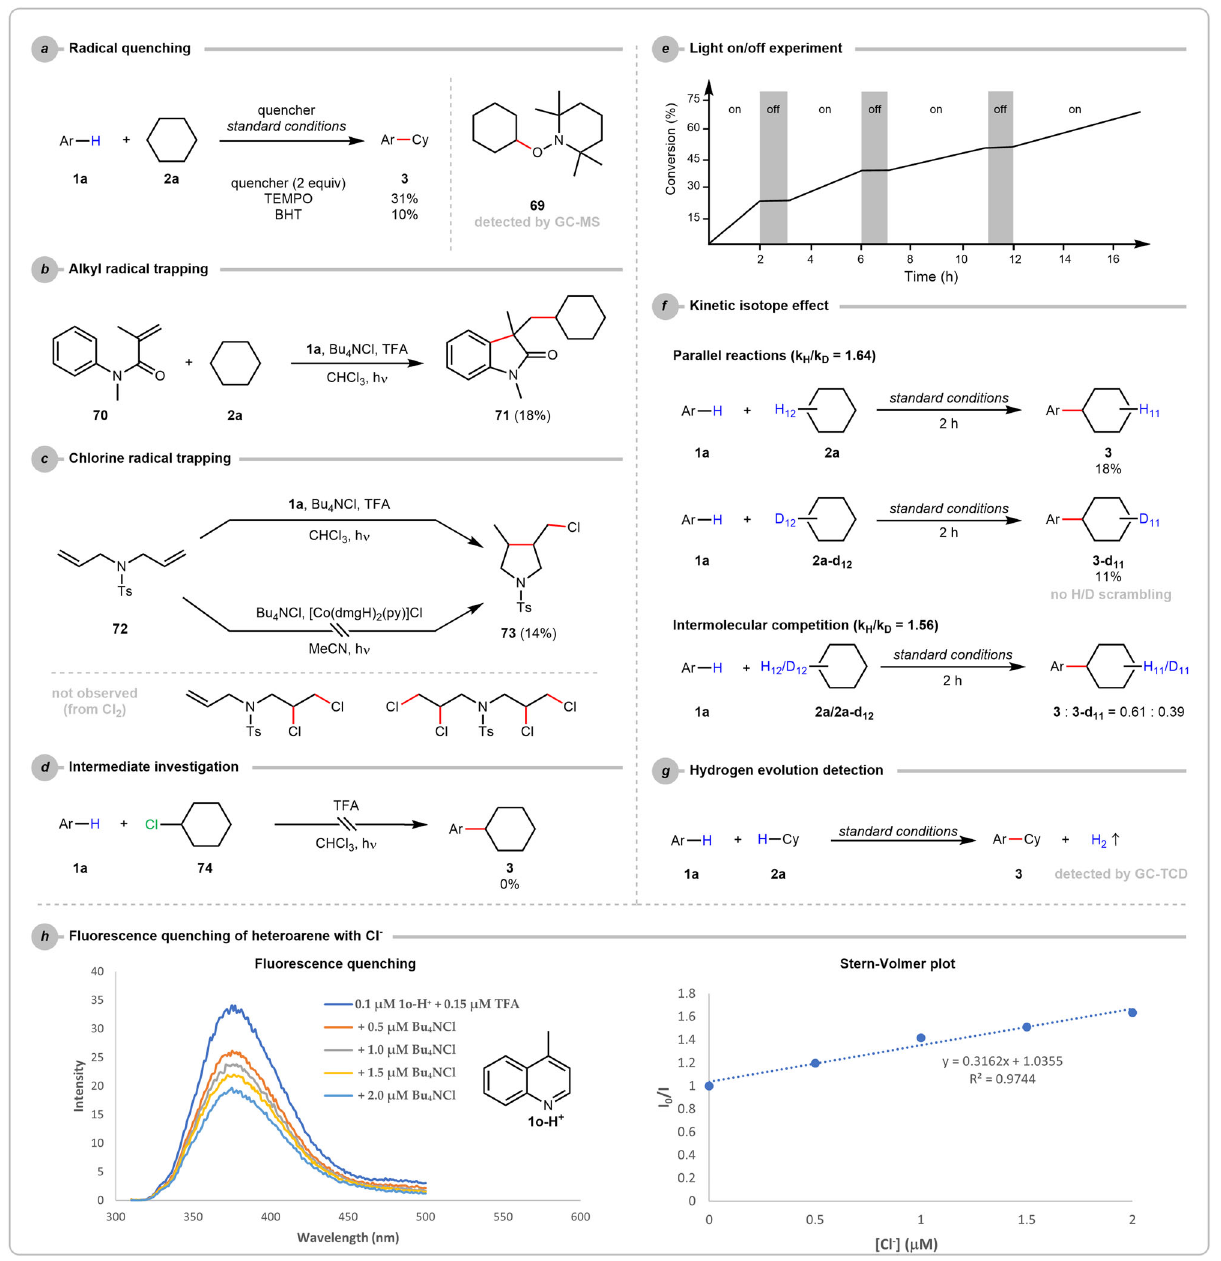
Fig. 4 Mechanistic studies. See Supplementary Information for more detailed reaction conditions and descriptions, including a radical quenching, b R· trapping, c Cl· trapping, d intermediate investigation, e light on/off experiment, f kinetic isotope effect, g H 2 detection, and h fl uorescence quenching. Ar = 2-phenylquin-4-yl, Cy, cyclohexyl. TEMPO 2,2,6,6-tetramethylpiperidine 1-oxyl, BHT 3,5-di- tert -4-butylhydroxytoluene; dmg dimethylglyoxime, TFA tri fl uoroacetic